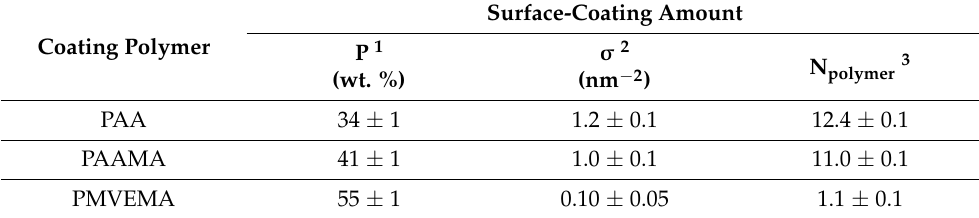
Figure 6. TGA curves of polymer-coated Pt-NPs (polymer = PAA, PAAMA, and PMVEMA).